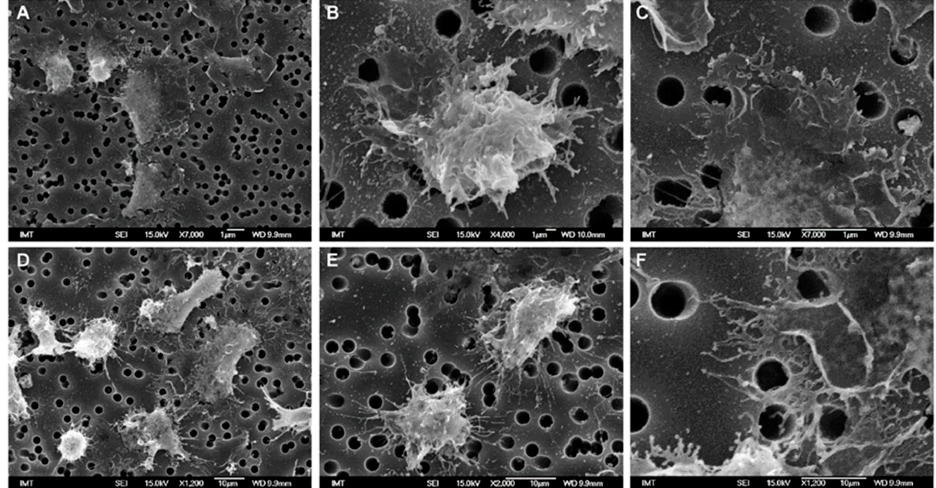
Figure 3. SEM images of hemocytes of M. galloprovincialis incubated for 30 min with PS ‐ NH 2 in ASW suspension ( A , B ) and in HS suspension ( D , E ). Details of membrane structures observed in ASW ( C ) and HS ( F ).